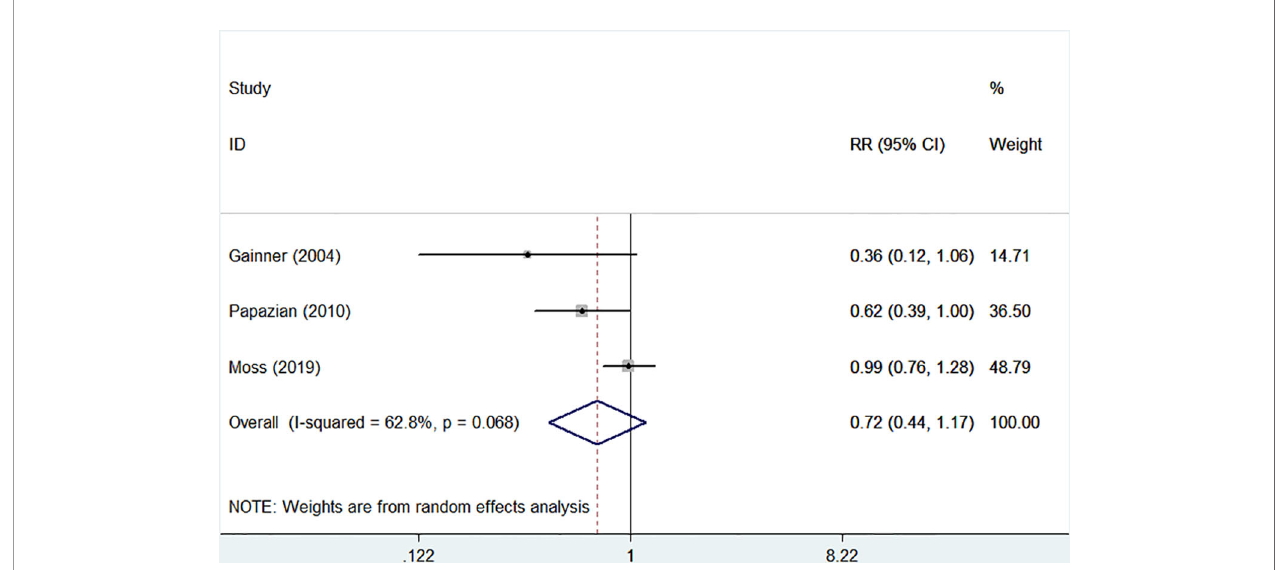
FIGURE 2 | Forest plot of RR and 95% CI for 28-day mortality. Three studies included 1,401 patients (706 in the NMBA group vs. 695 in the control group). The overall estimate based on the random-effect model showed that NMBA infusion did not reduce the 28-day mortality (33.4% vs. 37.1%, RR = 0.72, 95% CI 0.44 to 1.17, P = 0.180, I-squared = 62.8%).